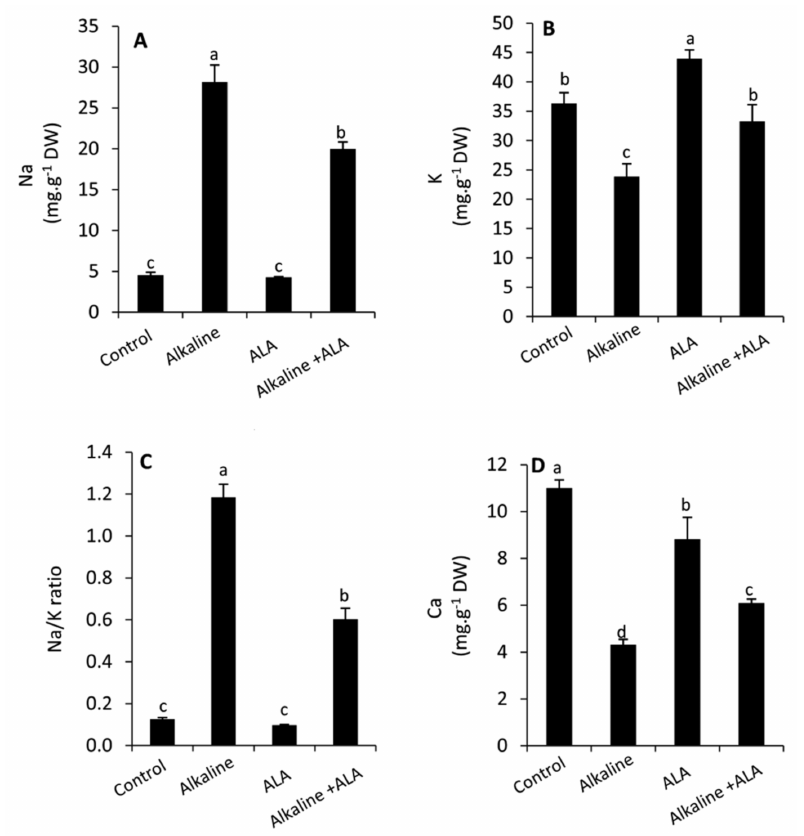
Figure 6. Effect of exogenous α -lipoic acid (ALA; 20 µ M) on the concentration of Na ( A ) K ( B ) Na/K ratio ( C ) and Ca ( D ) in the leaves of wheat seedlings grown under sodic alkaline